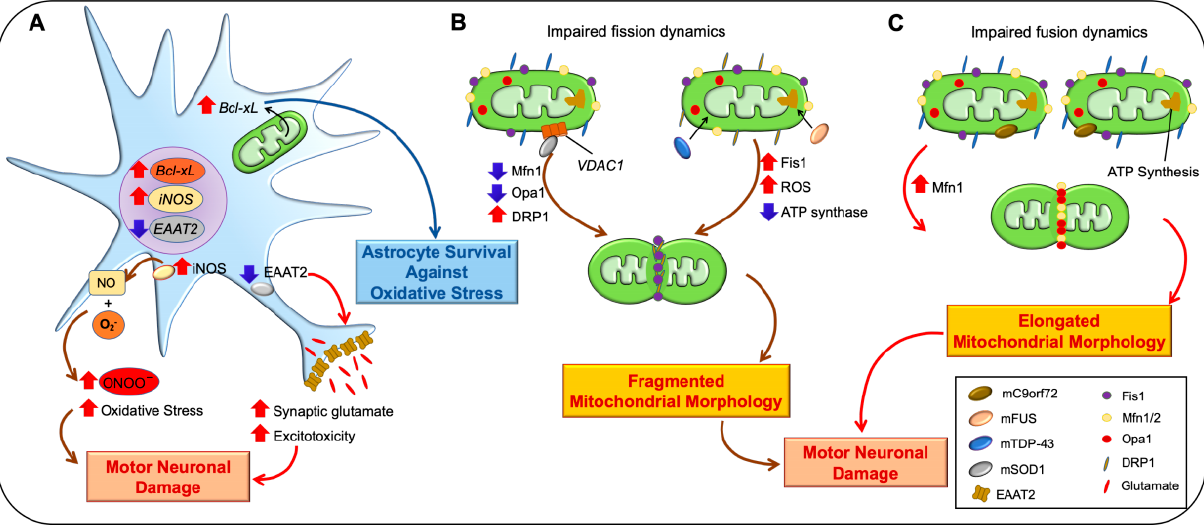
Figure 2. Mitochondrial dysfunction in amyotrophic lateral sclerosis (ALS). ( A ) B-cell lymphoma-extra large (Bcl-xL) gene expression is increased in astrocytes in response to cellular stress. The increase of Bcl-xL prevents oxidative damage in astrocytes under ALS conditions. Furthermore, inducible nitric oxide synthase (iNOS) expression in reactive astrocytes facilitates an interaction of superoxide (O 2- ) with nitric oxide (NO) that forms peroxynitrite (ONOO - ). Moreover, reduction of excitatory amino acid transporter 2 (EAAT2) levels inhibits glutamate uptake in the synaptic cleft, elevates the synaptic glutamate, and triggers motor neuronal damage and cell death. ( B ) Mutated FUS and mutated TAR DNA-binding protein 43 (mTDP-43) are localized to mitochondria, increase mitochondrial fission 1 protein (Fis1) and ROS levels, and subsequently decrease ATP synthesis activity. In addition, mutated superoxide dismutase 1 (SOD1), FUS, and TDP-43 impair mitochondrial fission dynamics and lead to mitochondrial fragmentation and apoptosis. ( C ) Mutated C9orf72 increase mitofusion-1 (Mfn1) and abnormal mitochondrial fusion.